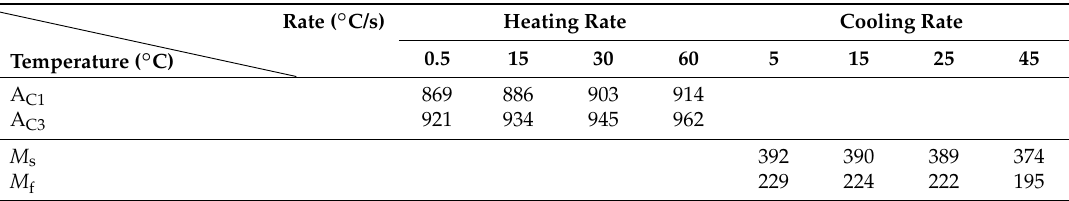
Table 1. The transformation temperatures of T92 steel determined by a dilatometer at specific heating/cooling rates.